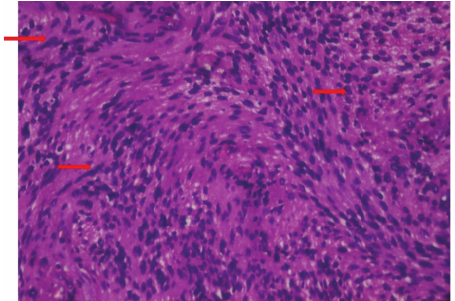
Figure 5: Photomicrograph showing spindle cells with wavy nuclei to round to ovoid nuclei indistinct cytoplasmic borders arranged in interlacing fascicles (H&E 40x).